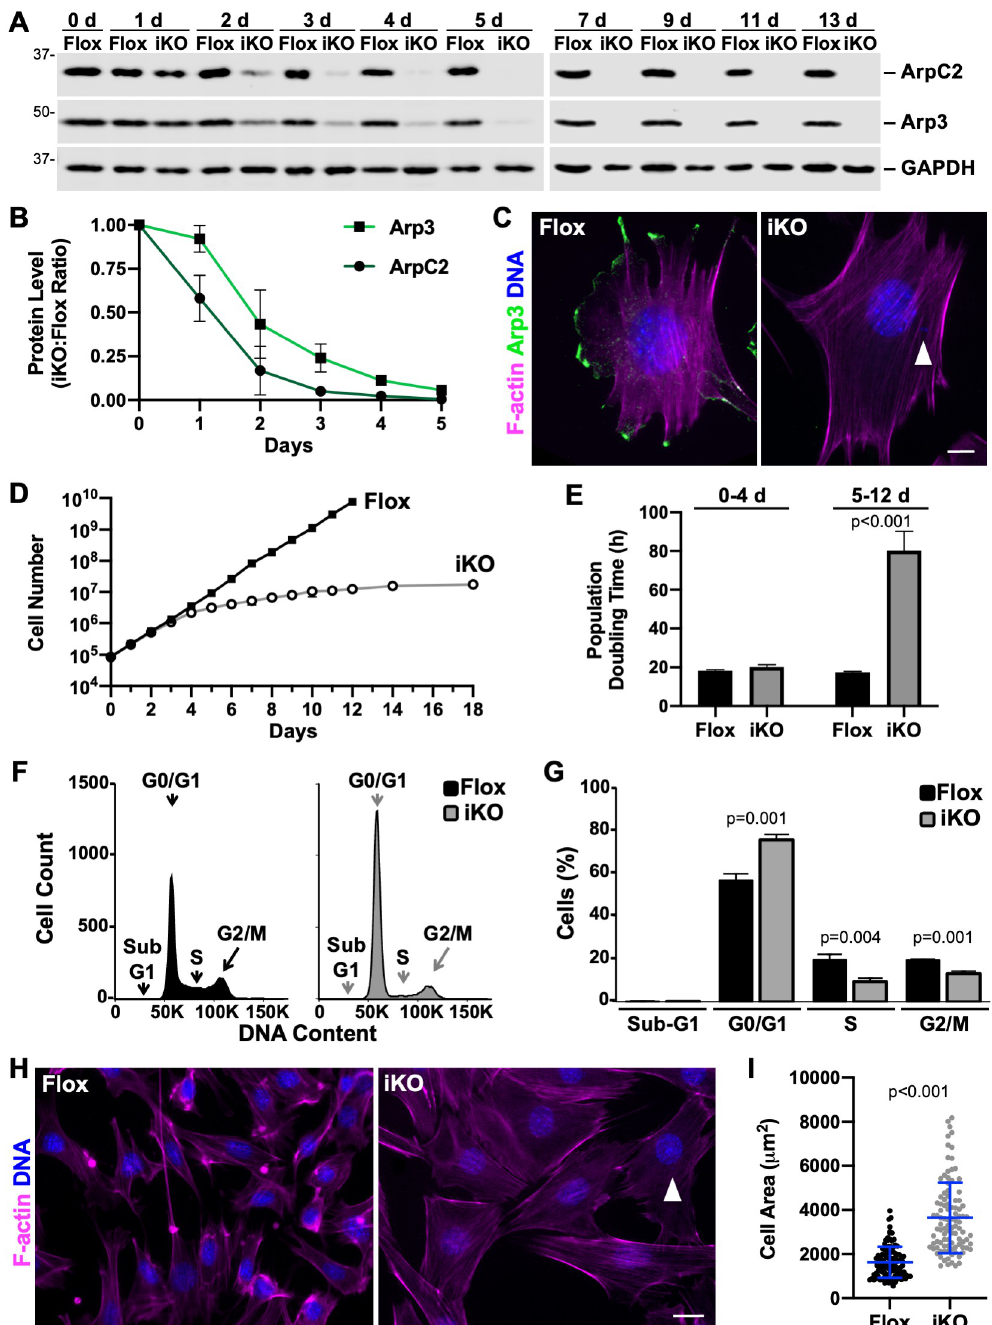
Fig 1. ArpC2 iKO cells undergo a proliferation arrest and enlargement. (A) Mouse fibroblasts were treated with DMSO (Flox) or 4-OHT (iKO) for 0-6d and collected at 0-13d. Samples were lysed, subjected to SDS-PAGE, and immunoblotted with antibodies to ArpC2, Arp3, and GAPDH. (B) ArpC2 and Arp3 band intensities were normalized to GAPDH or tubulin band intensities and plotted as the iKO:Flox ratio. Each dot represents the mean ratio ± SD from n = 2–3 experiments. (C) Flox and iKO cells were fixed at 7d and stained with phalloidin (F-actin; magenta), an Arp3 antibody (green), and DAPI (DNA; blue). The arrowhead highlights a micronucleus. Scale bar, 10 μ m. (D) Flox and iKO cell titers were quantified at 0- 18d. Each point represents the mean ± SD from n = 2 Flox and n = 2–3 iKO experiments, except for the 14d and 18d timepoints, which were from a representative iKO sample that did not exhibit outgrowth of colonies expressing ArpC2. (E) Flox and iKO population doubling times were quantified daily from 0-4d and 5-12d. For each time range, the bar represents the mean doubling time ± SD from n = 3 experiments. (F) Flox and iKO cells were fixed at 9d, stained with propidium